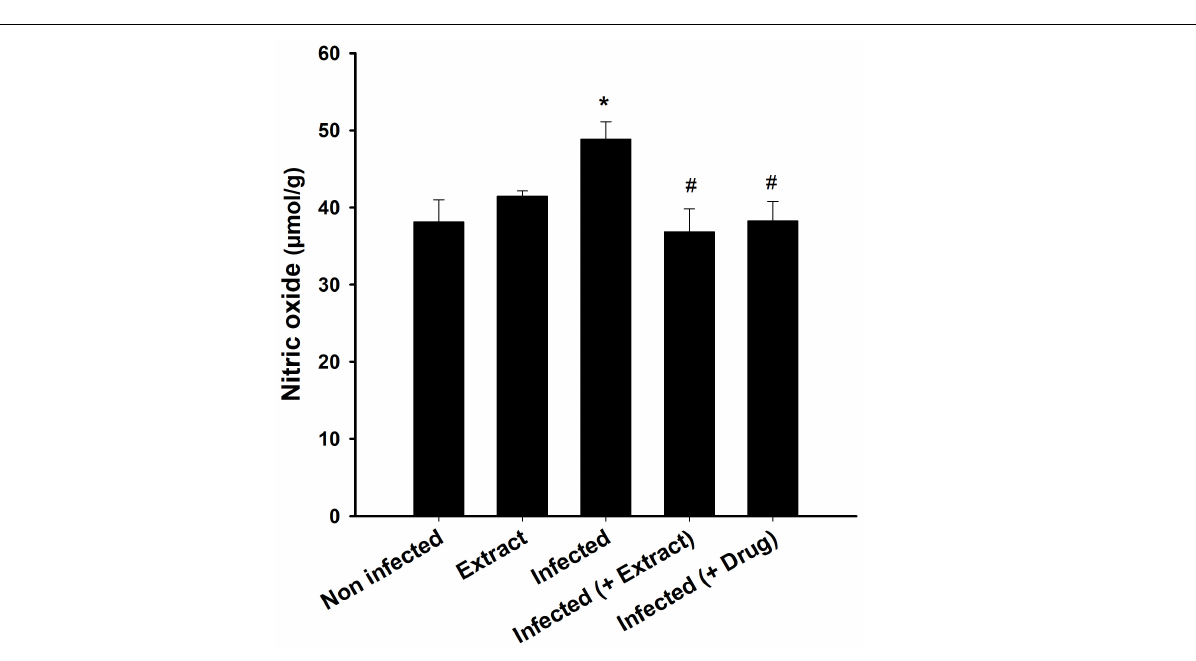
FIGURE 8 | Brain nitric oxide level after treatment of T. evansi -infected mice with E. camaldulensis . *, significance against control group at p ≤ 0.01. # , significance against infected group at p ≤ 0.01.